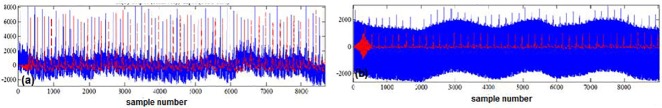
Illustration of the performance of the of the optimally factored-cascade IFIR implementation of H(z), when the input (in blue) is an ECG signal contaminated with different levels of noise: (a) The power of the noise is the same as the power of the signal; (b) The power of the noise is 100 times more than the power of the signal.